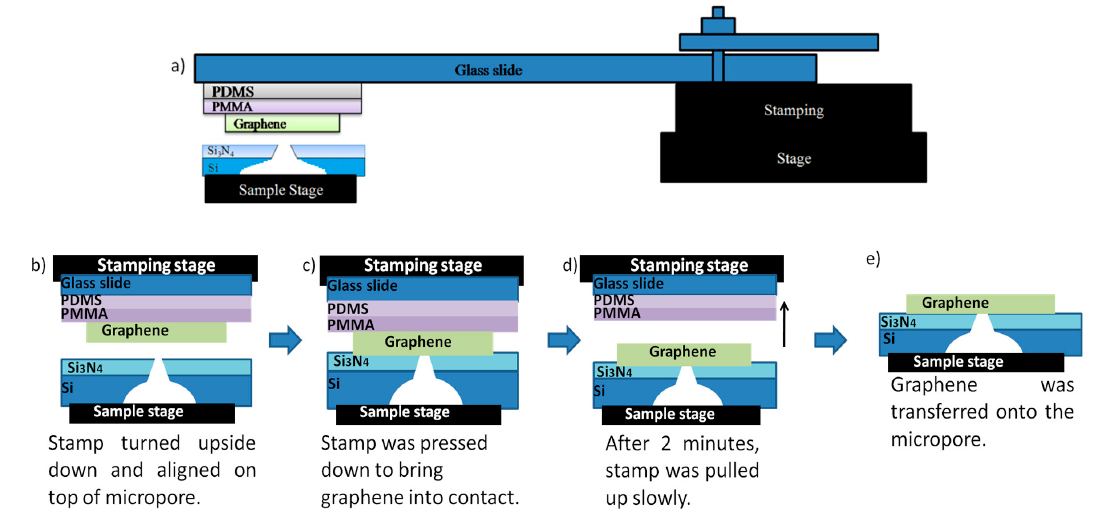
Figure 2. Schematic of the all-dry transfer method of graphene onto the Si micropore ( a ) the micromanipulator was used to adjust the position of the graphene on the micropore ( b ) stamping and sample stage structures were prepared ( c ) graphene was brought into contact with the micropore ( d ) and ( e ) stamping stage was retracted with graphene left on the micropore.